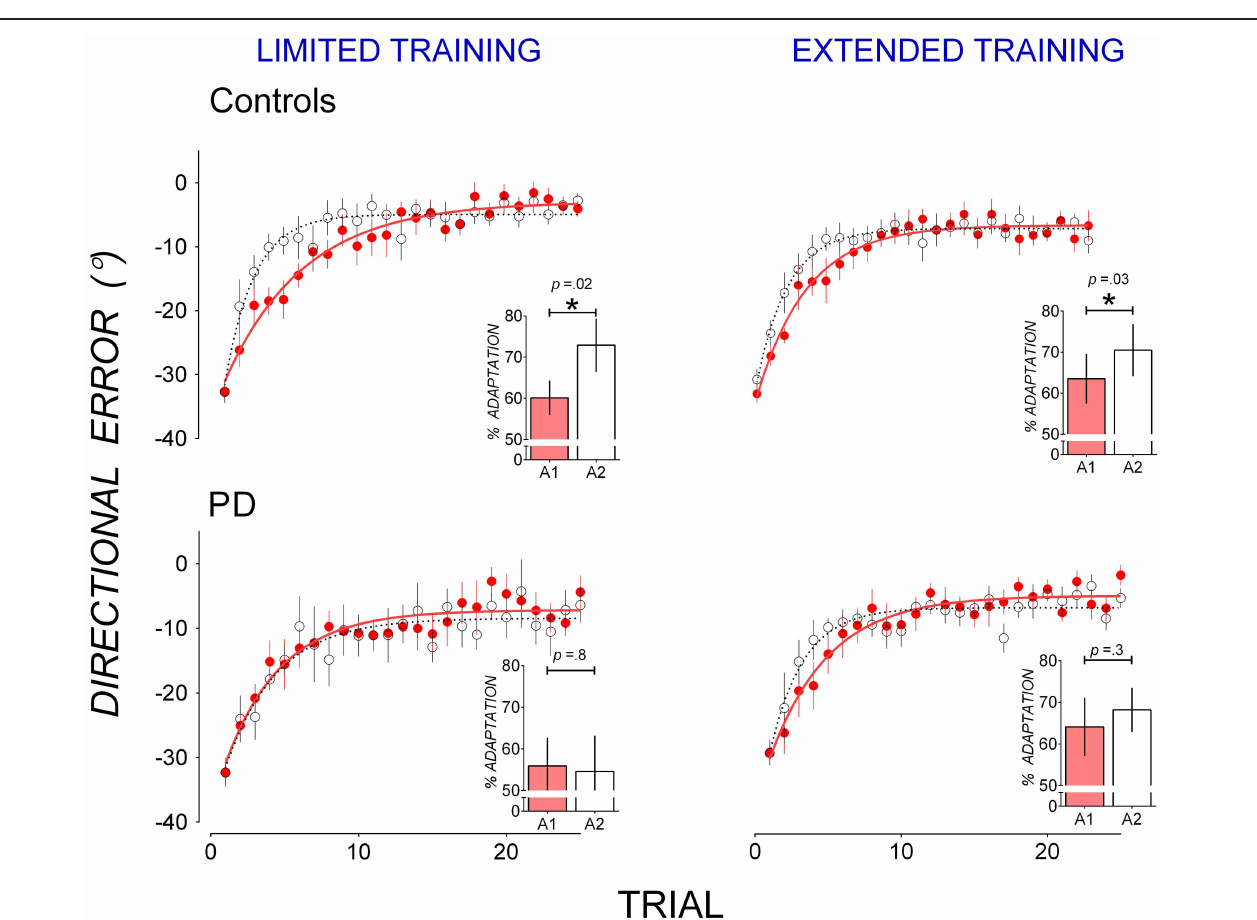
FIGURE 2 | Mean trial-by-trial directional error in A1 (closed, red circles) and A2 (open circles) in controls (top panels) and PD patients (bottom panels) for the limited training condition (left panels) and the extended training condition (right panels). A single-exponential function was fit to